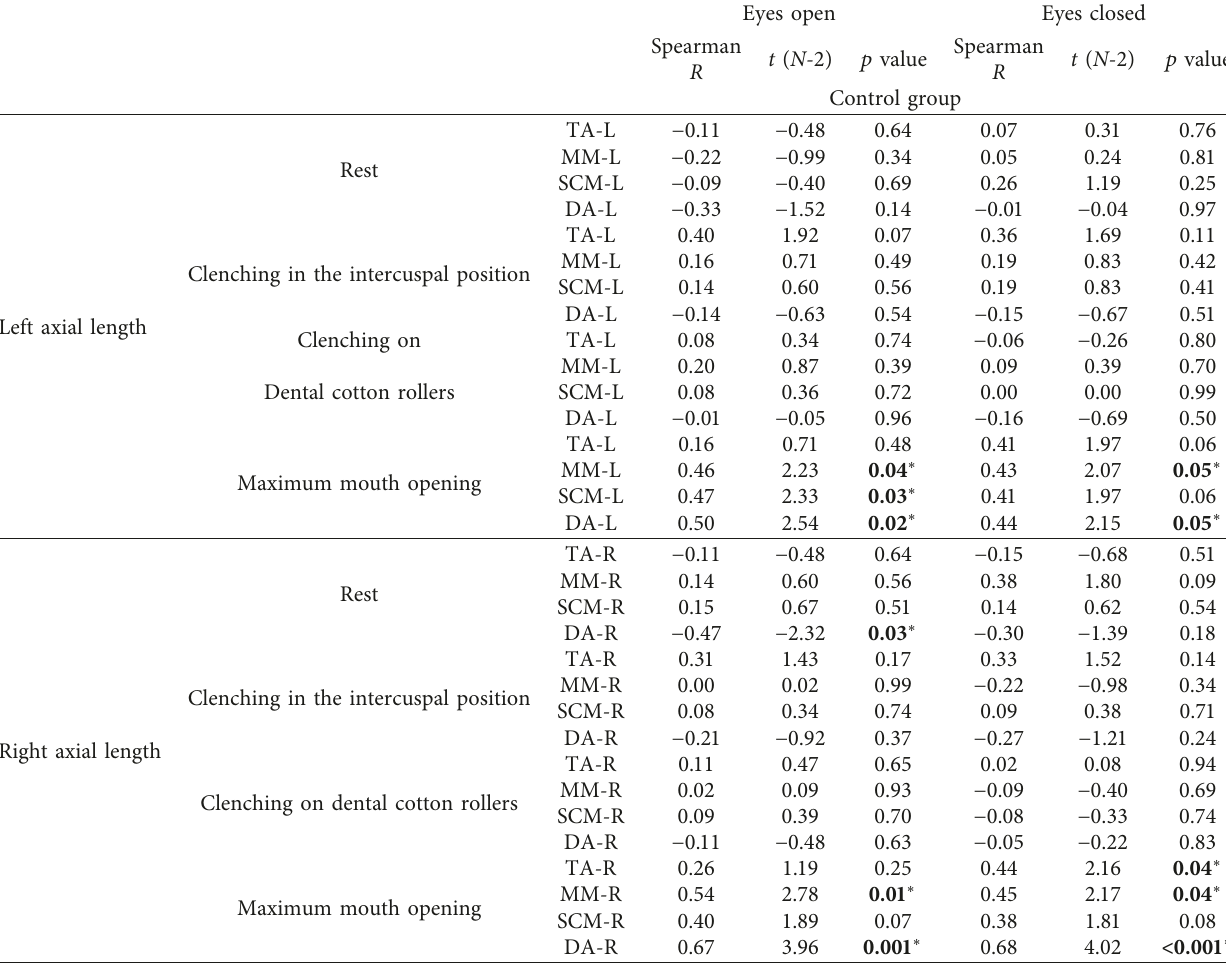
Table 4: Pooled correlation results in healthy